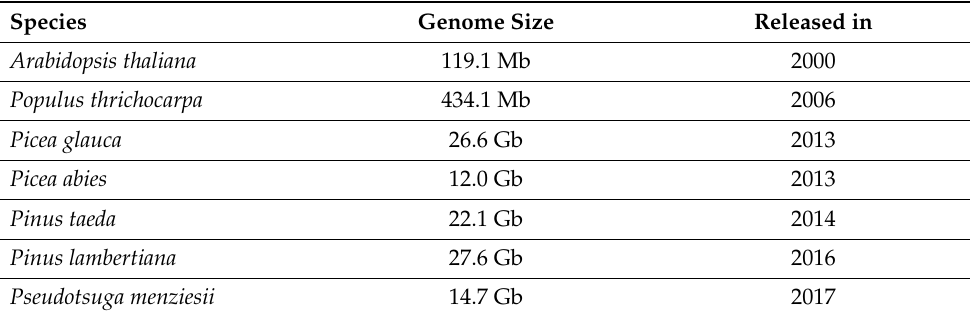
Table 2. A comparison between the genome size of different species. Species Genome Size Released in Arabidopsis thaliana 119.1 Mb 2000 Populus thrichocarpa 434.1 Mb 2006 Picea glauca 26.6 Gb 2013 Picea abies 12.0 Gb 2013 Pinus taeda 22.1 Gb 2014 Pinus lambertiana 27.6 Gb 2016 Pseudotsuga menziesii 14.7 Gb